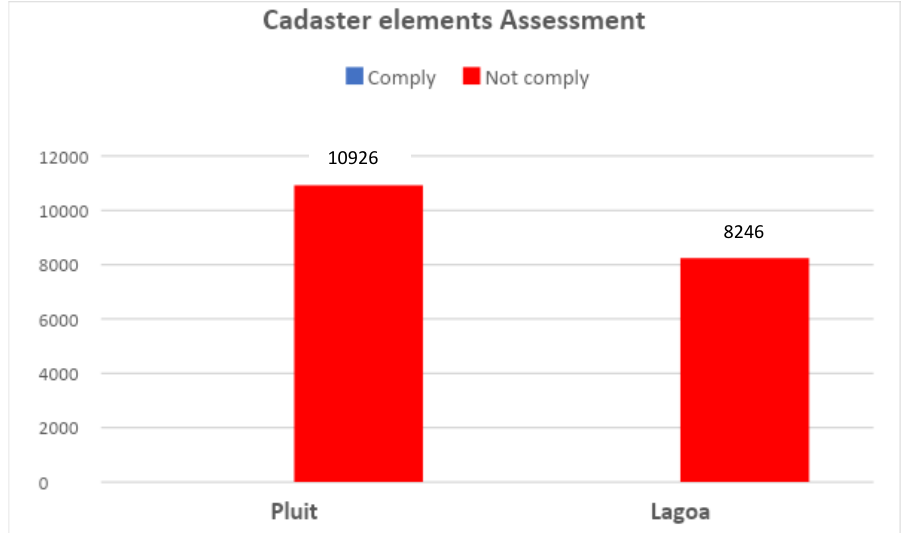
Figure 3. Appropriateness of spatial cadastre elements in Pluit and Lagoa Wards.